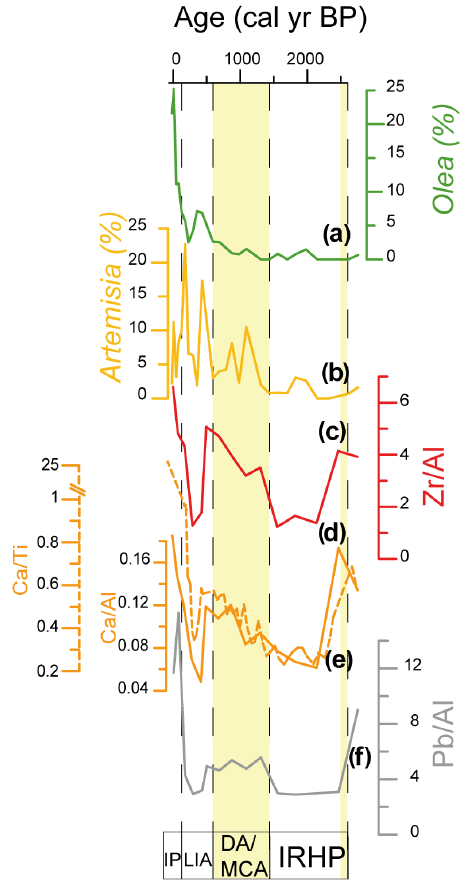
Figure 8. Comparison of geochemical proxies with pollen taxa, re- lated to anthropogenic impact for the last ∼ 2600calyrBP. (a) Olea percentage from LH; (b) Artemisia percentage from LH record; (c) Zr / Al ratio from LH; (d) Ca / Al ratio from LH; (e) Ca / Ti (XRF) ratio from LH in dashed line; (f) Pb / Al ratio from LH. Yellow bands indicate more arid intervals. Dark dashed lines are used for separating the different current era periods: IRHP: Iberian Roman Humid Period; DA: Dark Ages; MCA: Medieval Climate Anomaly; LIA: Little Ice Age; IP: Industrial